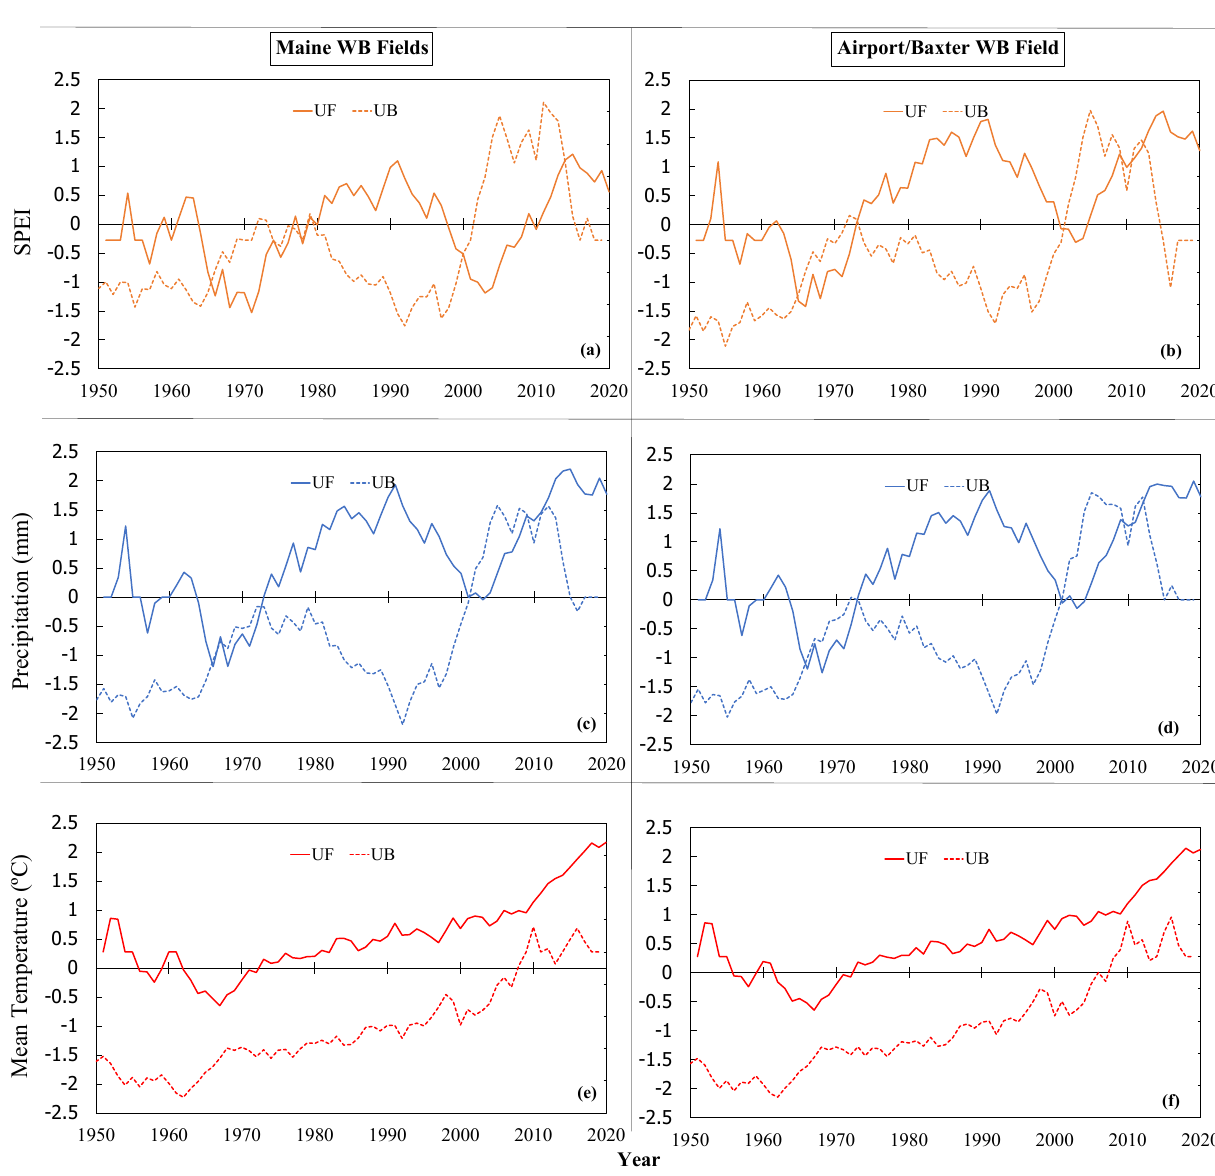
Figure 4. Sequential Mann–Kendall test statistics (UF and UB values) calculated from the ( a , b ) SPEI_6 of September; ( c , d ) mean precipitation (average of May–September); ( e , f ) average air temperature (average of May–September) throughout the major wild blueberry production region in Maine, as well as at the Airport/Baxter wild blueberry fields in Deblois, ME. Here, the upward UF curve (forward trend) mostly being > 0.0, UB (backward trend) curve mostly being < 0.0, and UF and UB not intersecting with each other indicate the significant increasing trends of the mean temperature. The intersections of the curves with the 0.0 line as well as with each other represent the non-significant changing (increasing/decreasing) trends of the SPEI and precipitation.